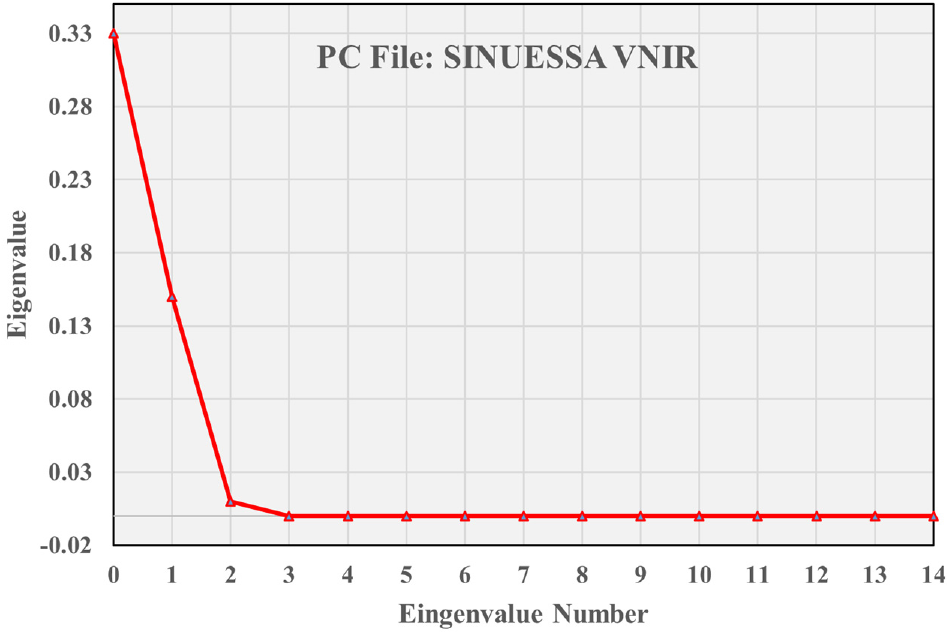
Figure 10. Sinuessa: PCA (eigenvalues) in the VNIR dataset; the PCA plot shows that the information is concentrated in the first three components; in particular the highest values are found in PC-1, PC-2. Relatively to Sinuessa, the PCA in the VNIR PRISMA dataset highlighted the geo- morphological characteristics of the study area (Figure 13) in the continental zone, the whole northern ignimbritic domain; moreover, along the coast, emerged and submerged morphology are clearly distinguishable (in sequence: emerged beach, submerged beach, submerged